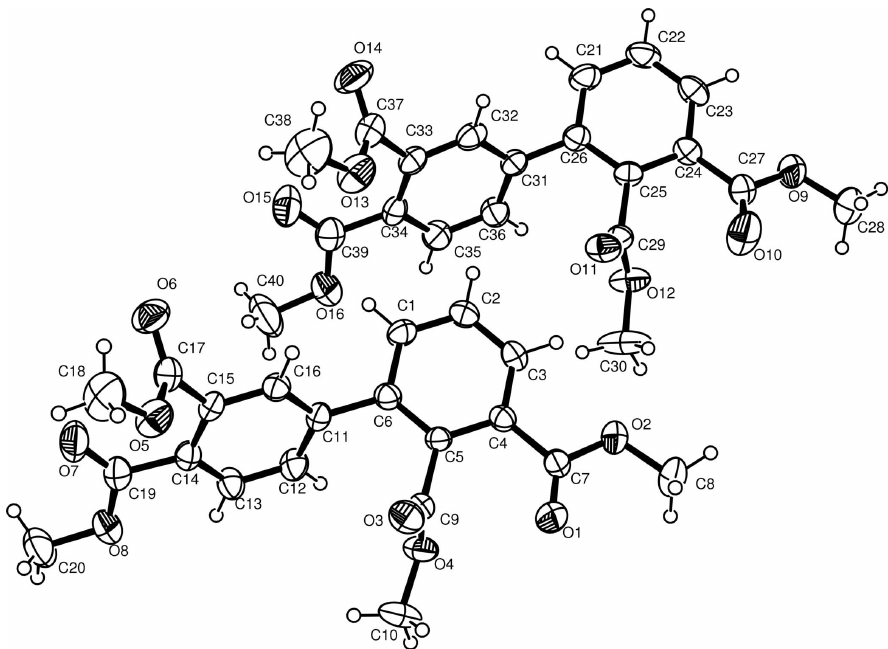
Figure 1 The molecular structure of I with the atom numbering scheme. Displacement ellipsoids are drawn at the 30% probability level. H atoms are presented as a small spheres of arbitrary